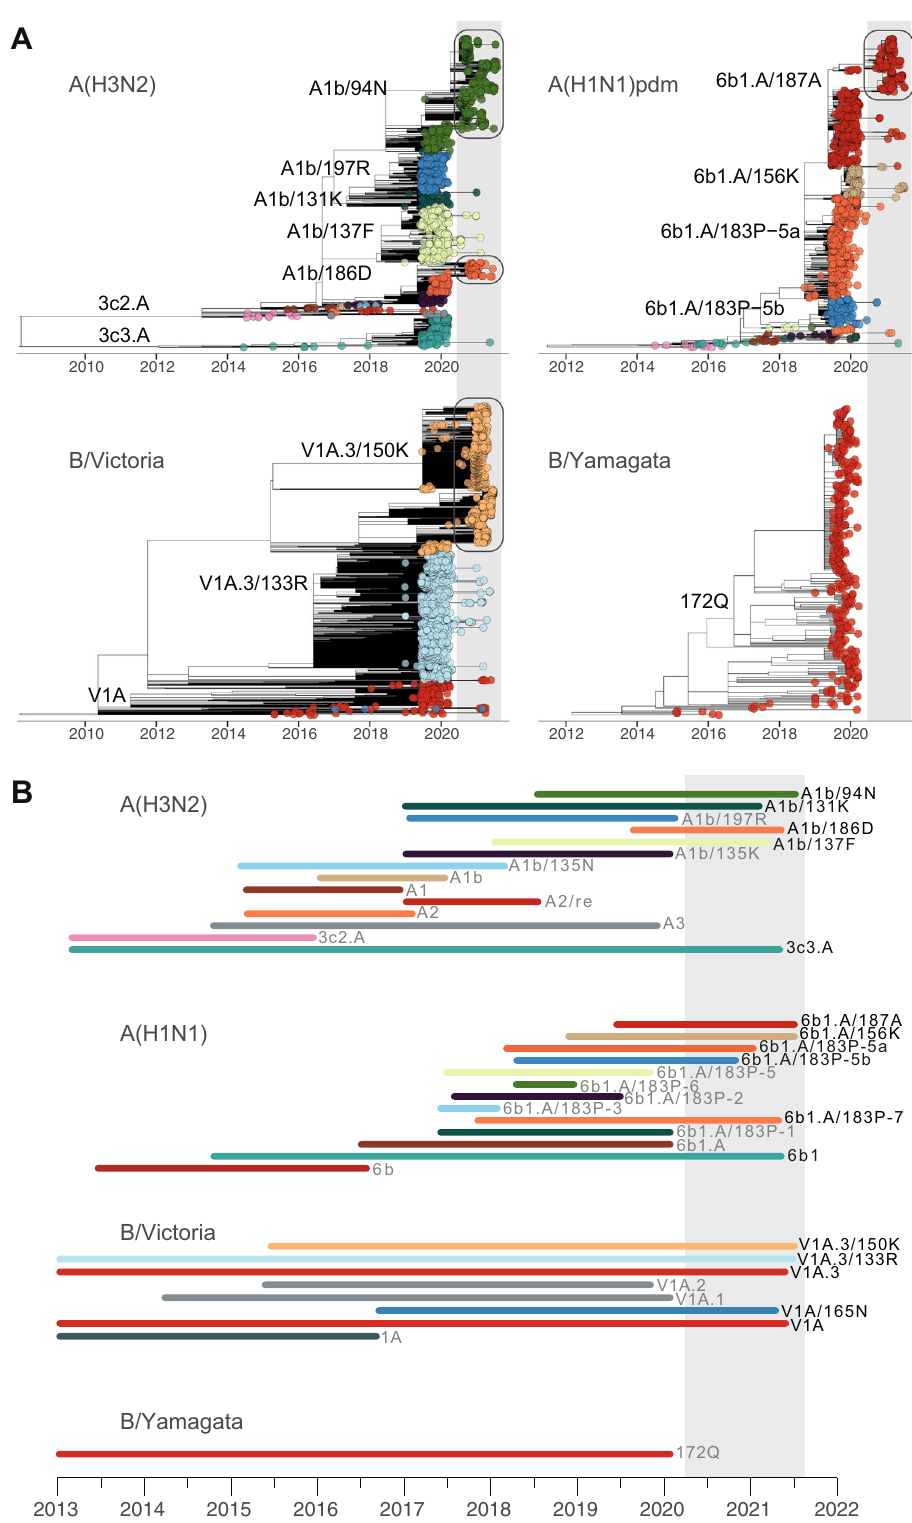
Fig. 3 Comparison of seasonal in fl uenza virus evolution before and since COVID-19 emergence. A Evolutionary relationships and divergence times of HA genes inferred using maximum likelihood (see Online Methods section). Tips are colored by WHO clade designations. Phylogenetic trees of major clades that continued to circulate during 2020/2021 (marked in A ) are shown in Supplementary Figs. 1 – 4, including A(H3N2) clades A1b/94N and A1b/186D; A(H1N1) clade 6b1.A/187A lineages in West Africa; and B/Victoria lineages from several regions around the world. B Timeline of recently circulating seasonal in fl uenza virus HA clades from mean estimated divergence time to most recent sequence. Time since the onset of the COVID-19 pandemic is shaded in